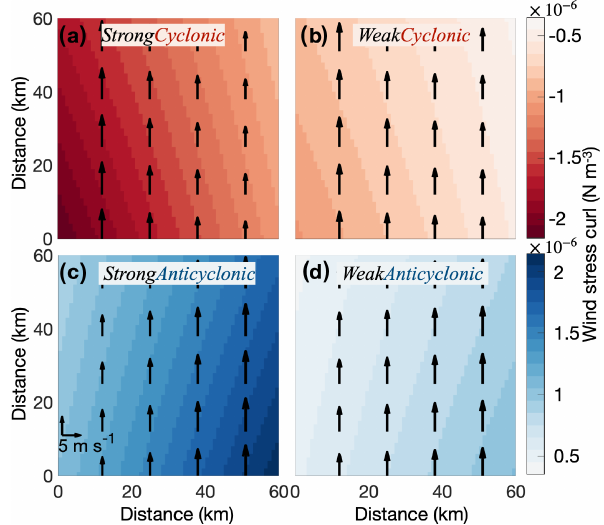
Figure 6. Wind fields applied in this study. (a) The wind field rep- resenting simplified climatological conditions in the southeastern Amundsen Sea. (b) Same as (a) , but with wind stress curl reduced by 50%. (c) Same as (a) , but anticyclonic. (d) Same as (c) , but with wind stress curl reduced by 50%. The arrows show wind stress (only every 13th arrow is plotted for clarity), with the scale on the southwestern corner of (c) . Shading shows wind stress curl, red for cyclonic and blue for anticyclonic.